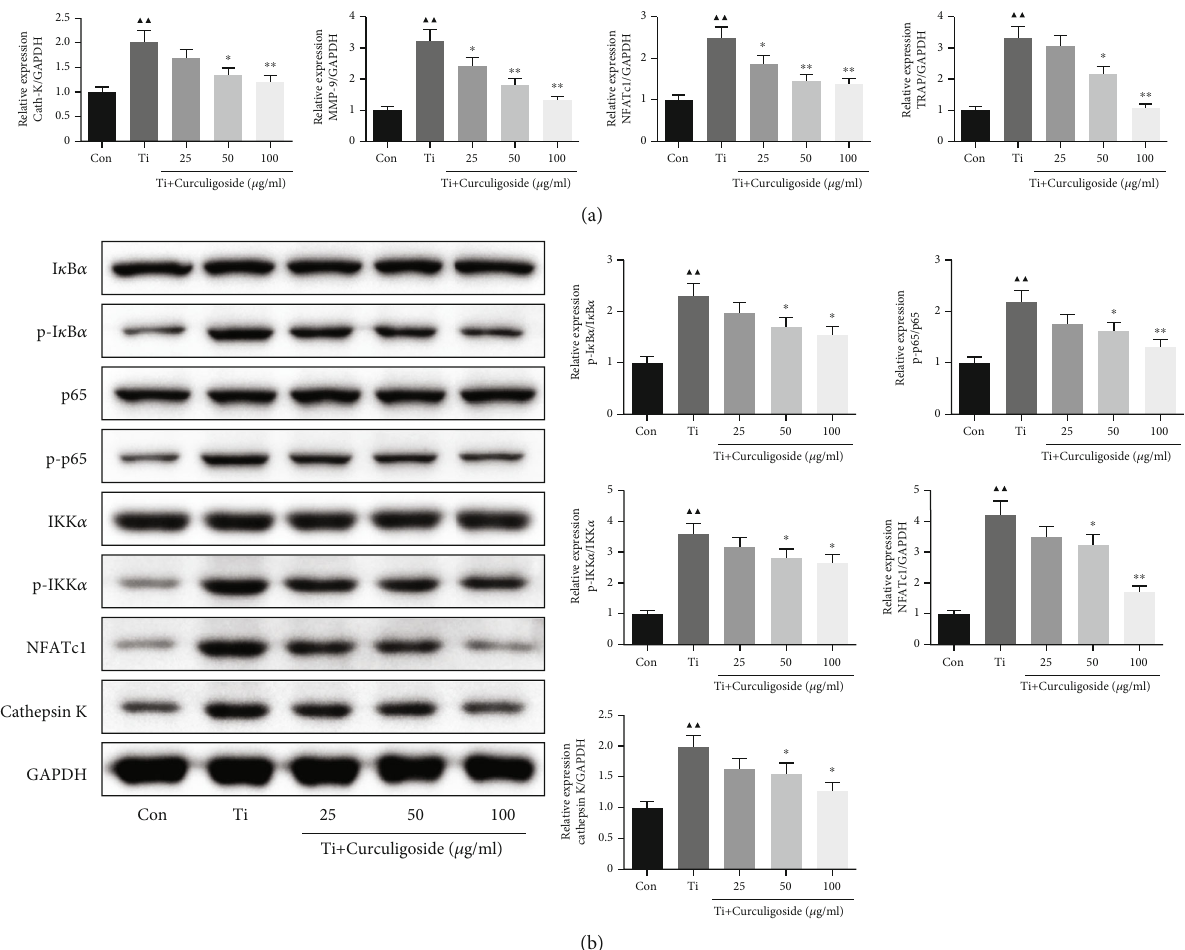
Figure 6: Curculigoside treatment alleviated osteoclast-associated gene expression in Ti-induced BMSCs. (a) qRT-PCR analysis was performed to detect the relative mRNA expression of cathepsin K, TRAP, NFATc1, and MMP-9 in BMSCs. (b) Western blot analysis was performed to detect the relative protein expression of I κ B α , p-I κ B α , p65, p-p65, IKK α , p-IKK α , NFATc1, and cathepsin K in BMSCs ( n = 3 ); results are represented as the mean ± SD . ▲ P < 0 : 05 , compared to the Con group; ▲▲ P < 0 : 01 , compared to the Con group; ∗ P < 0 : 05 , compared to the Ti group; ∗∗ P < 0 : 01 , compared to the Ti group. BMSCs: bone marrow stromal cells; Ti: titanium particles; Con: